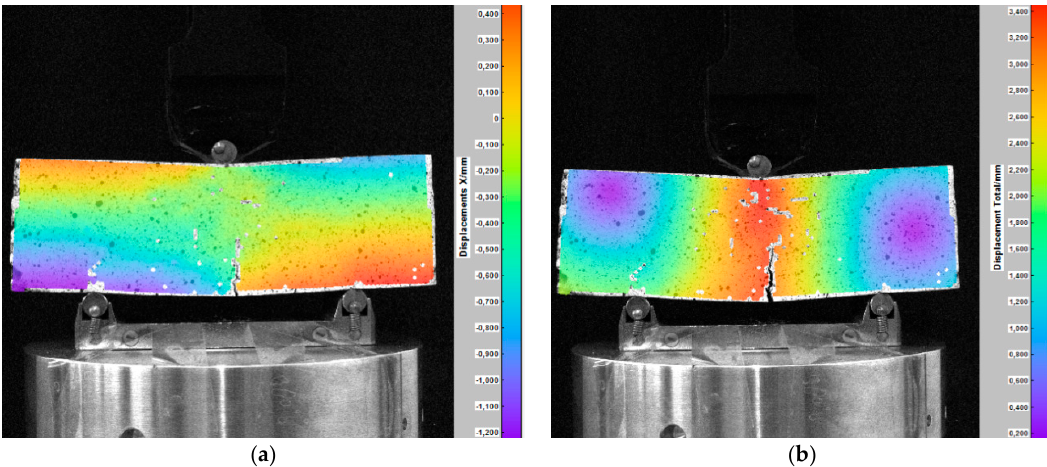
Figure 17. Horizontal displacements of a rock sample in a three-point bending test: ( a ) Initial phase of the test; ( b ) total displacement; final phase of the test - a clearly visible vertical crack in the sample.